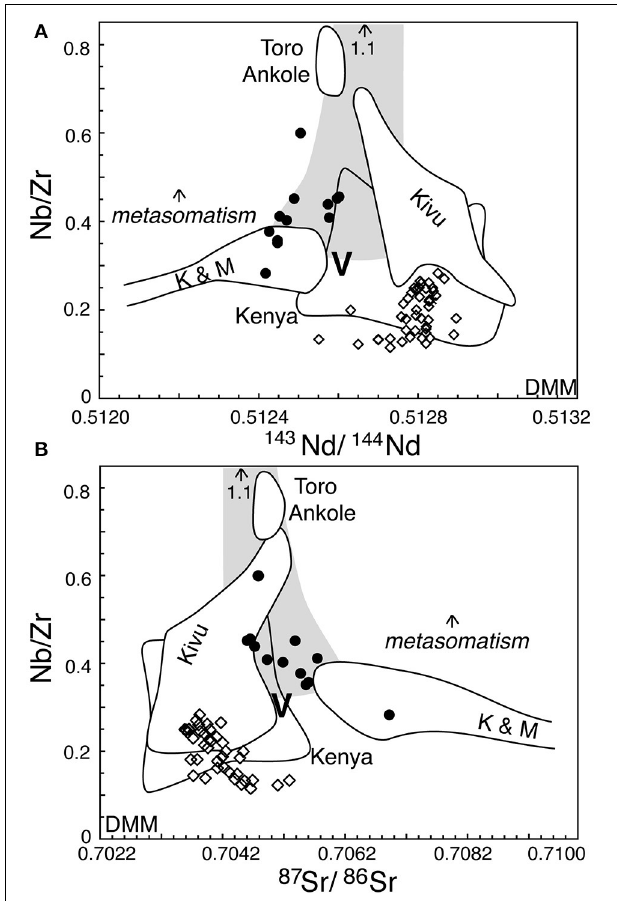
FIGURE 6 | Relationships between Nb/Zr and (A) 143 Nd/ 144 Nd and (B) 87 Sr/ 86 Sr ratios. These variations illustrate the effect of carbonatitic metasomatism in the source of EARS lavas. V represents the range of composition of the mantle plume responsible for such metasomatism. Generally, protracted metasomatism continuously affects incompatible trace element ratios of the lithopheric mantle, but at the same time converting its 143 Nd/ 144 Nd and 87 Sr/ 86 Sr ratios to the composition of mantle plume V. Consequently, it adds a fourth pseudo-endmember source of EARS lavas, which are products of variable mixing among the sources—V and 3 corners of the triangle. More explanations in the